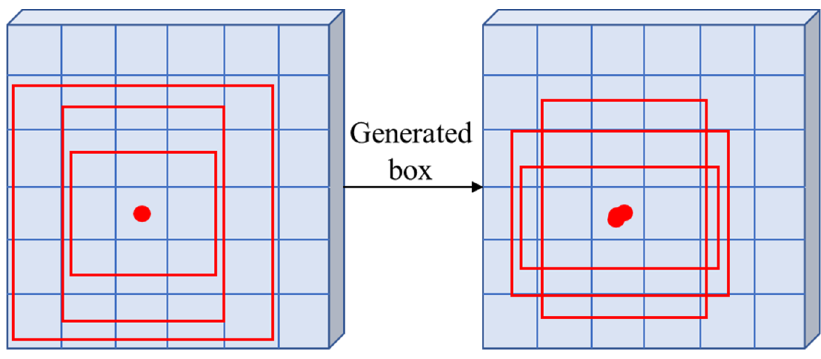
Figure 9. Priori box.